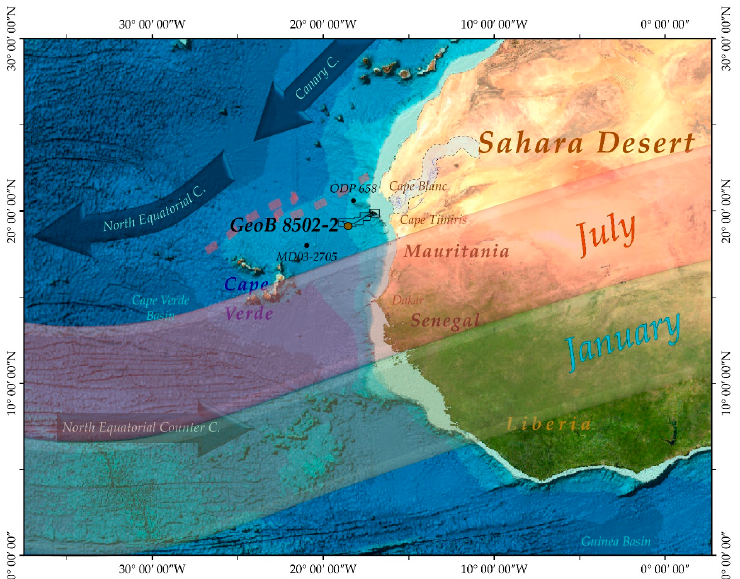
Figure 1. Location of the studied core GeoB 8502-2 along the north-western African margin compared with the atmospheric and oceanographic regional settings. The Cap Timiris Canyon pathway is marked. The arrows show the pathway of the modern dominant surface currents in the area. Red and blue bands identify the migration domains of the summer and winter intertropical convergence zone (ITCZ), respectively. The dashed red band close to the core position denotes the Cape Verde frontal zone (CVFZ) location. The Tamanrasett River paleodrainage valley is indicated, as suggested by [15] .